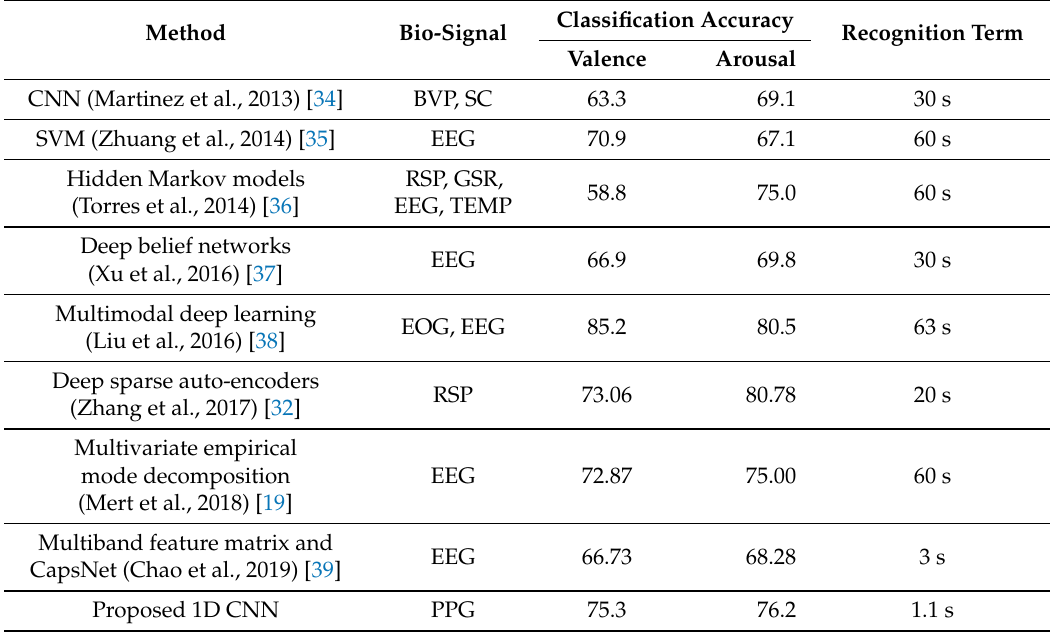
Table 1. Classification accuracy and recognition term for emotion recognition based on physiological signals. Method Bio-Signal